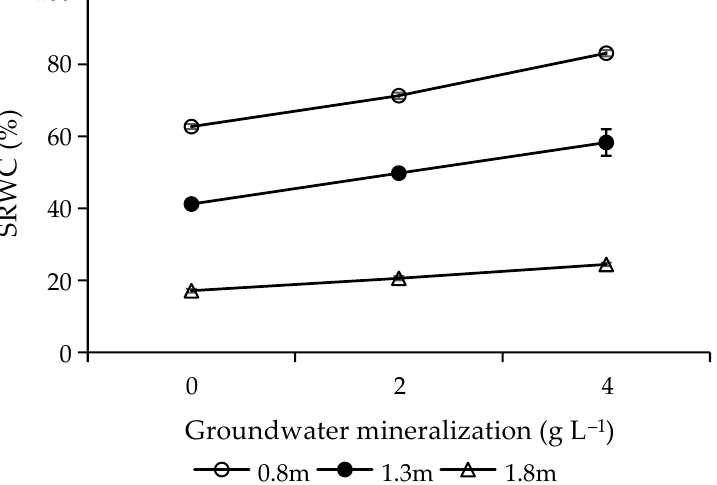
Figure 2. Effects of groundwater mineralization and groundwater depth on soil relative water content. Error bars indicate standard errors (SEs) of the mean.